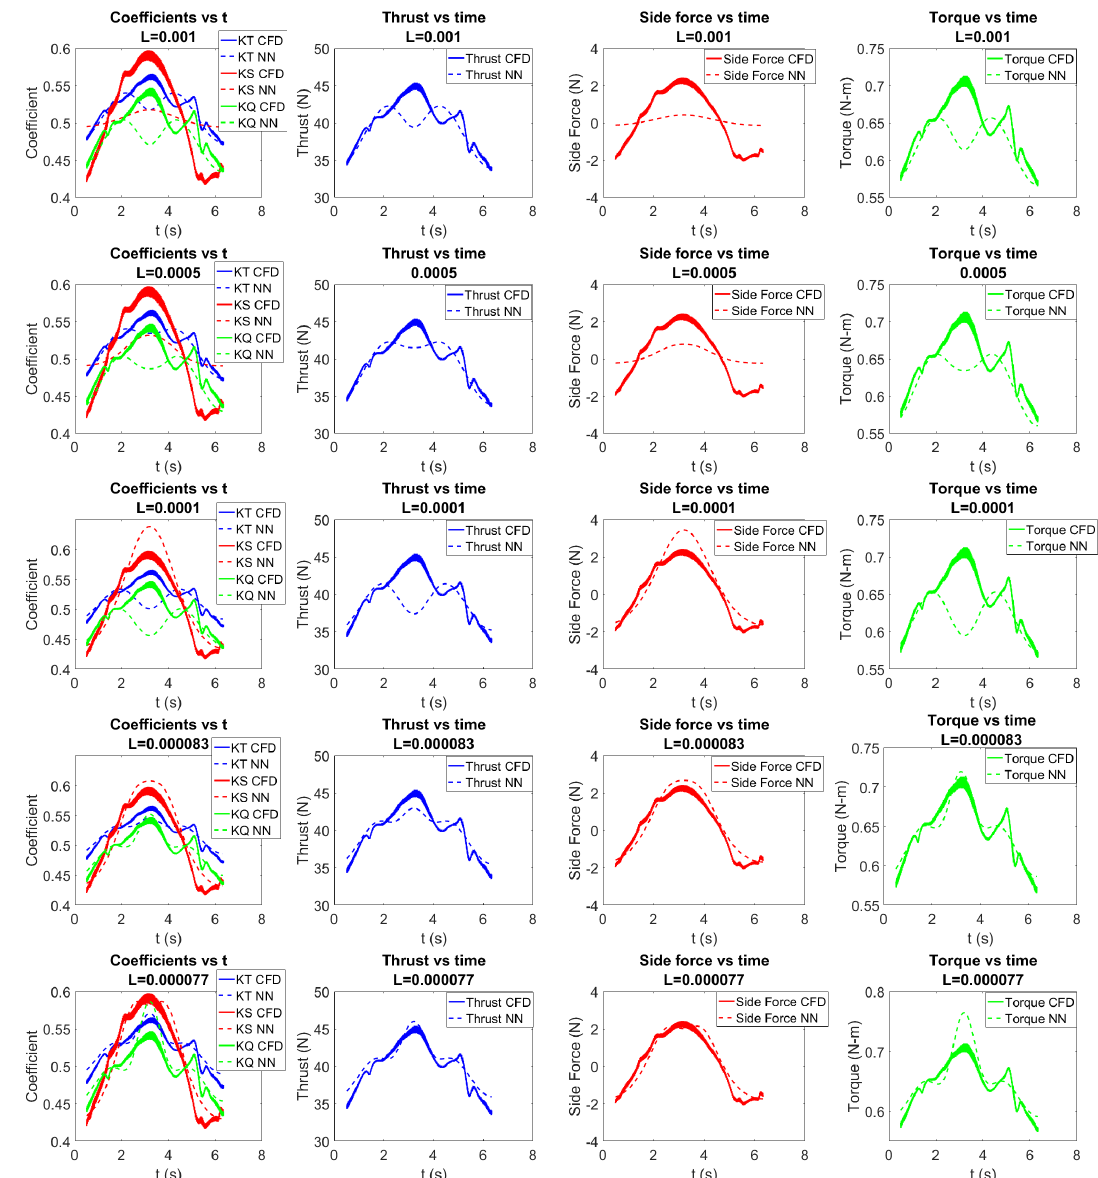
Figure 12. Coefficients, thrust, side force, and torque for behind condition neural network validation case. Top row: highest tolerance for L . Bottom row: lowest tolerance for L